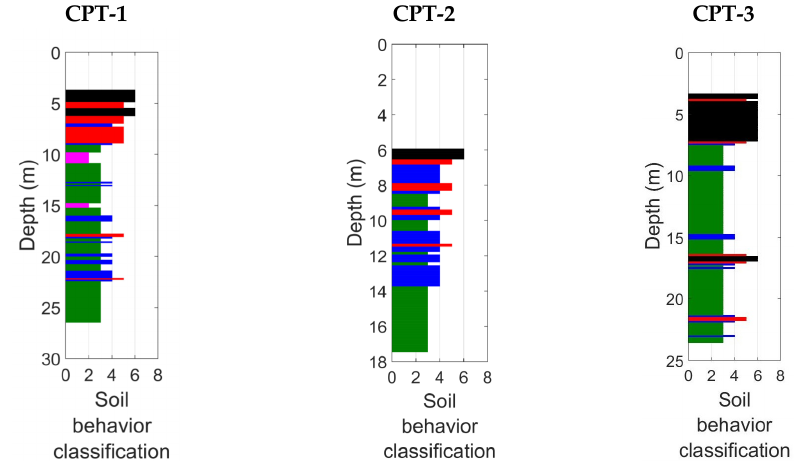
Figure 3. Site investigation at Saemangeum, Republic of Korea.